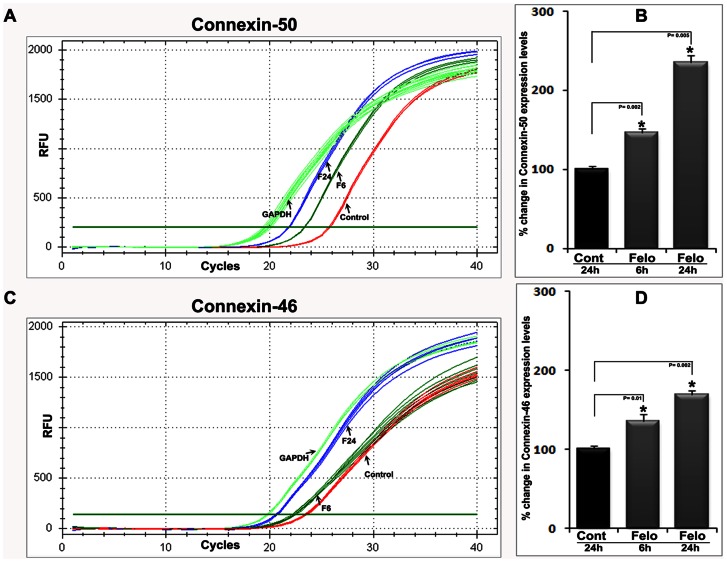
Upregulation of Connexin-50 and -46 gene expression in the felodipine treated mouse lenses.q-RT-PCR was performed to determine whether there is any difference in the transcriptional regulation of connexin gene expression in felodipine treated mouse lenses. For this, total RNA extracted from the felodipine treated (6 and 24 hrs) and control (DMSO treated) lenses was reverse-transcribed and used for q-PCR analyses. Real-time quantification of expression of connexin-50 and -46 genes was normalized to the cycle value (Cycles) of GAPDH. Left panels: plots of log fluorescence units versus cycle number. Right panels: relative percent fold change in connexin-50 and -46 gene expression with felodipine treatment in ex-vivo mouse lens. Fold changes were calculated based on the mean values from triplicate analyses of individual samples. F6 and F24 represent the 6 and 24 hr felodipine treated specimens, respectively.